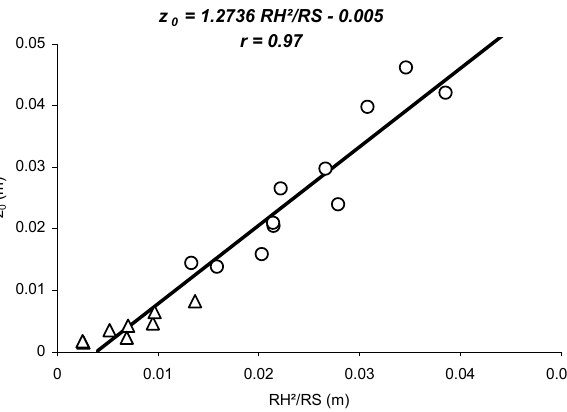
Fig. 3. Aerodynamic roughness length ( z 0 ) as a function of RH 2 /RS ( RH , ridge height; RS , ridge spacing). Circles: this study; triangles: Hagen and Armbrust (1992).